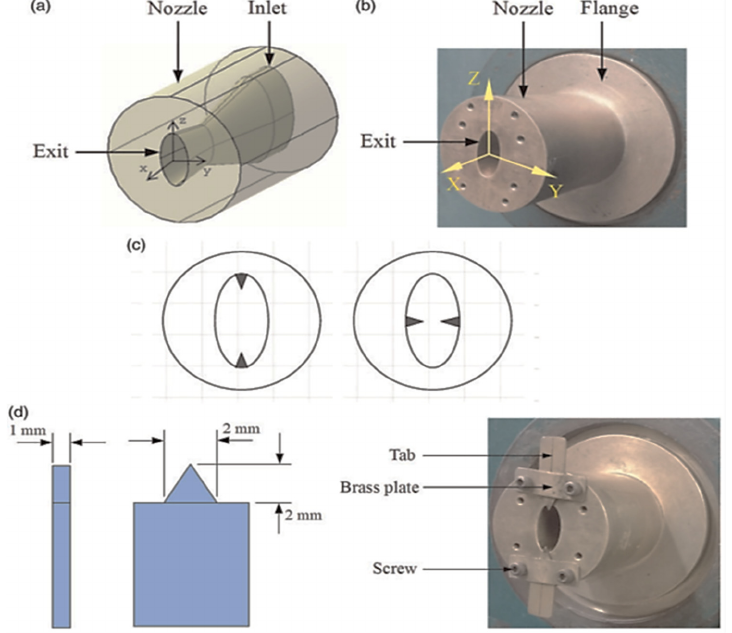
Figure 4. Jet control device, ( a ) Nozzle drawing, ( b ) Nozzle image without tabs, ( c ) Both minor and major tabs on the nozzle drawing ( d ) Triangular tabs dimension and nozzle image with major tabs